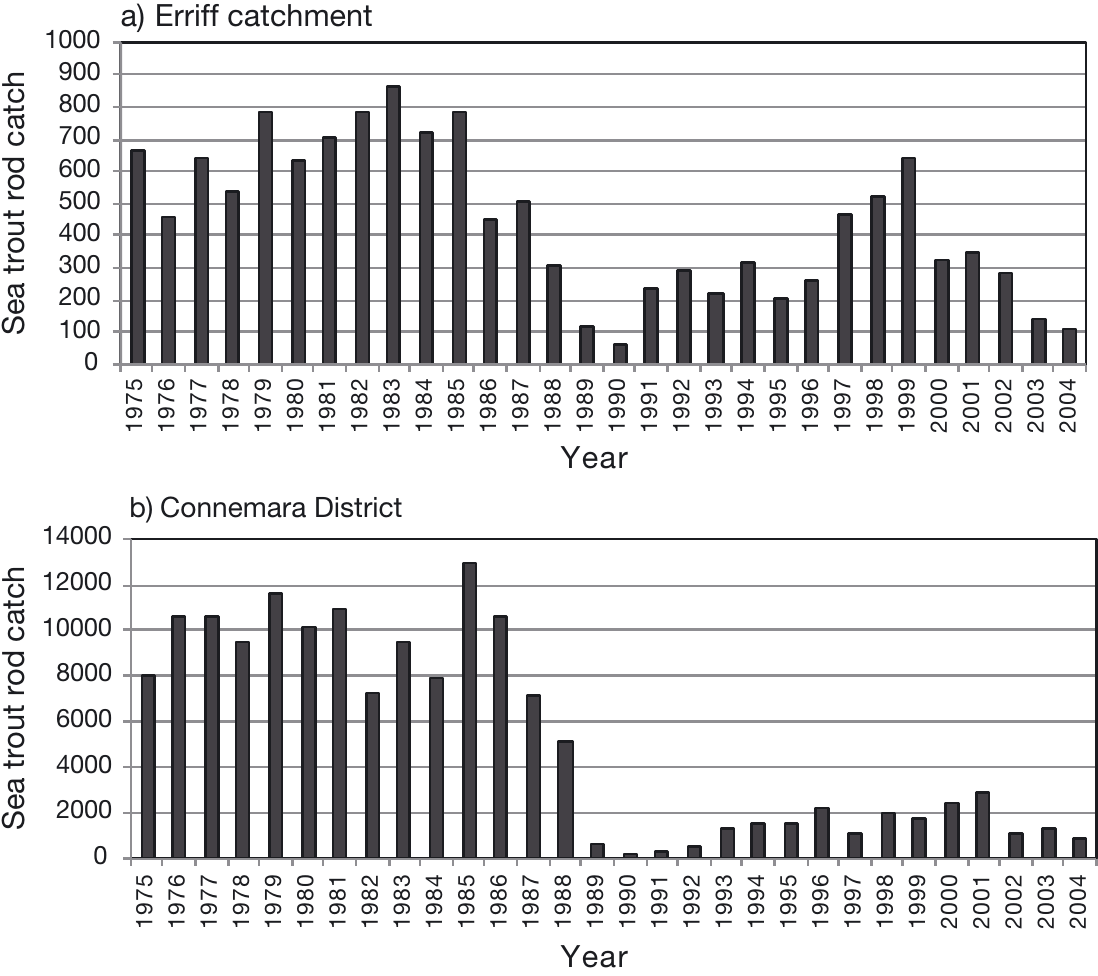
Fig. 2. Number of sea trout Salmo trutta rod catches for (a) the Erriff catchment and (b) the Connemara District, 1975−2004. Catch and release angling was applied from 1990